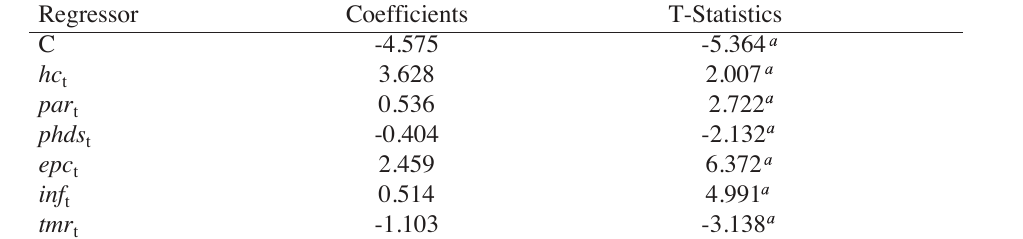
Table 5.3 Estimates of Long Run Cointegrating Vector.